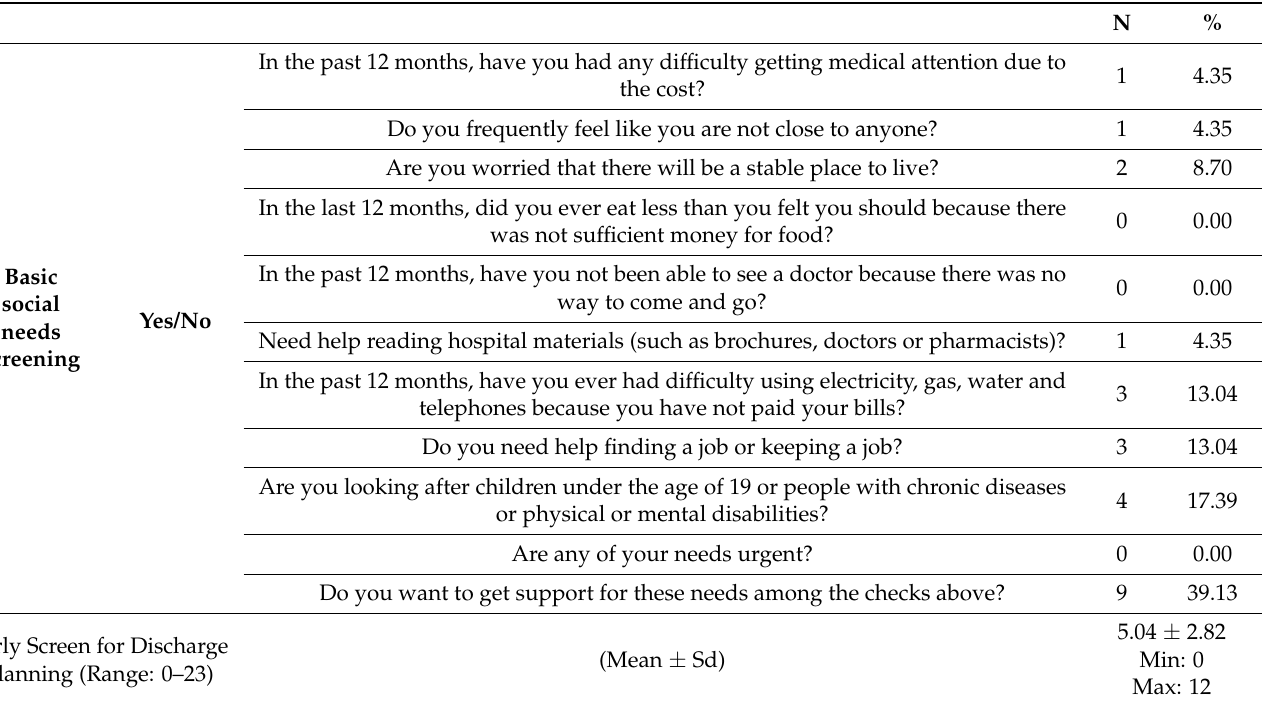
Table 2. Initial Screening